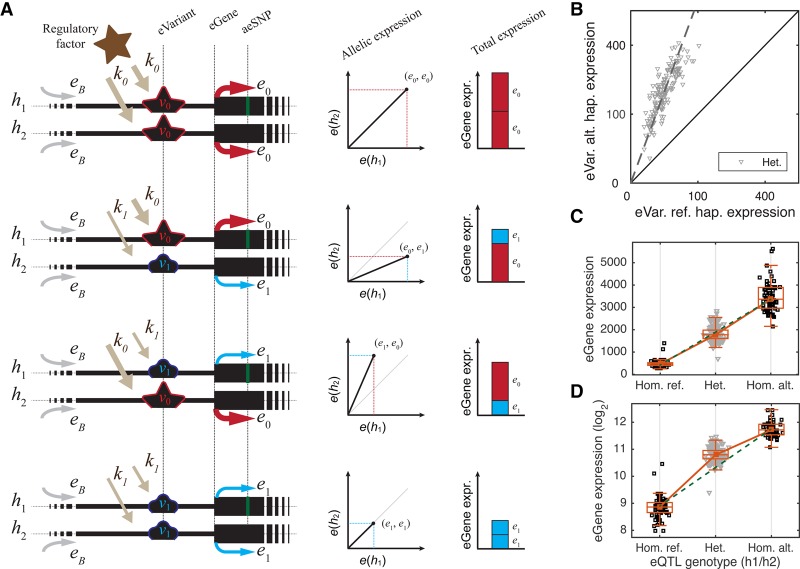
(A) Schematic representation of cis-regulatory eQTL model in Equations 1 and 2. (B) Example of allelic expression associated with each of the alleles of a cis-eQTL (eVariant Chr 5: 96252589 T/C; eGene ERAP2) in GTEx adipose subcutaneous. Each dot corresponds to allelic imbalance in one individual heterozygous for the eVariant, measured using reads that overlap heterozygous SNPs (aeSNP) in the eGene. Phasing between the aeSNP and the eQTL SNP is utilized to associate the measured allelic expression with each of the eQTL alleles. (C,D) eGene expression for the same example eQTL. The green dashed line connects the median expression of the two homozygous classes. Expression is linear with number of alternative alleles (C), but the linearity is lost after log transformation (D).